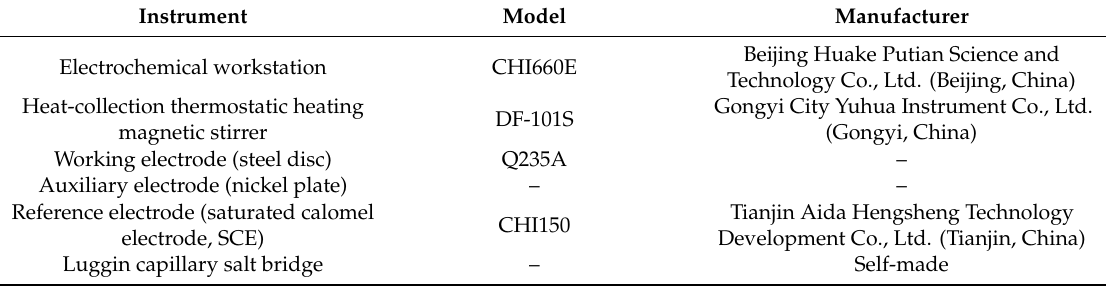
Table 3. Instruments used for electrochemical